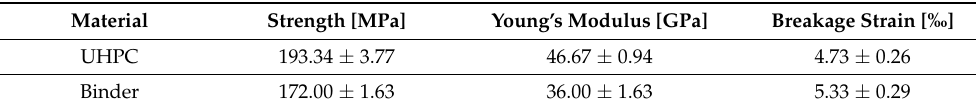
Table 2. Mechanical properties of UHPC and binder obtained from experimental tests.